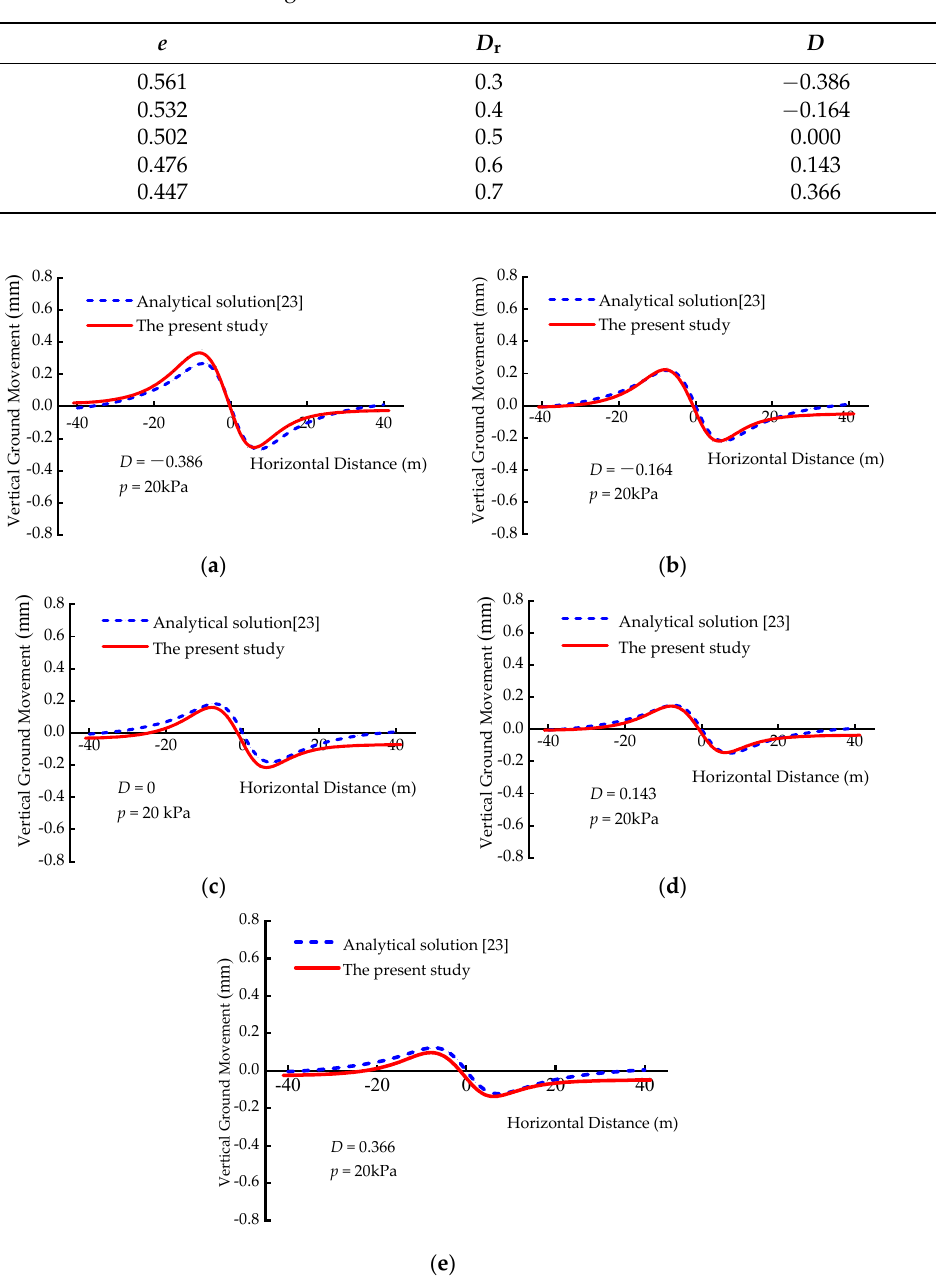
Figure 16. Vertical ground movements due to additional thrust at different disturbed states. ( a ) D = − 0.386; ( b ) D = − 0.164; ( c ) D = 0; ( d ) D = 0.143; ( e ) D = 0.366.